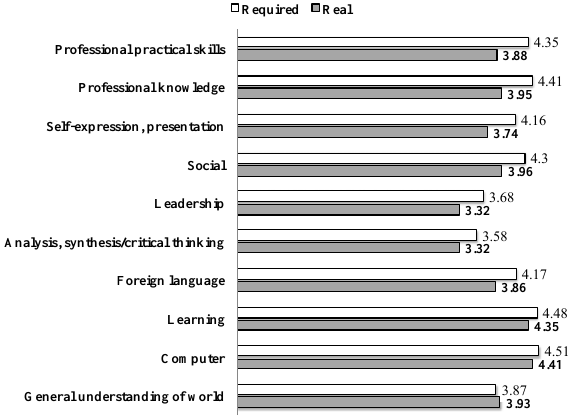
Figure 4. Graduates Comparing Technical and Non-Technical Compe- tences Required for Their Jobs with Their Own Competence Level Surprisingly, 11% of respondents disagreed with the their